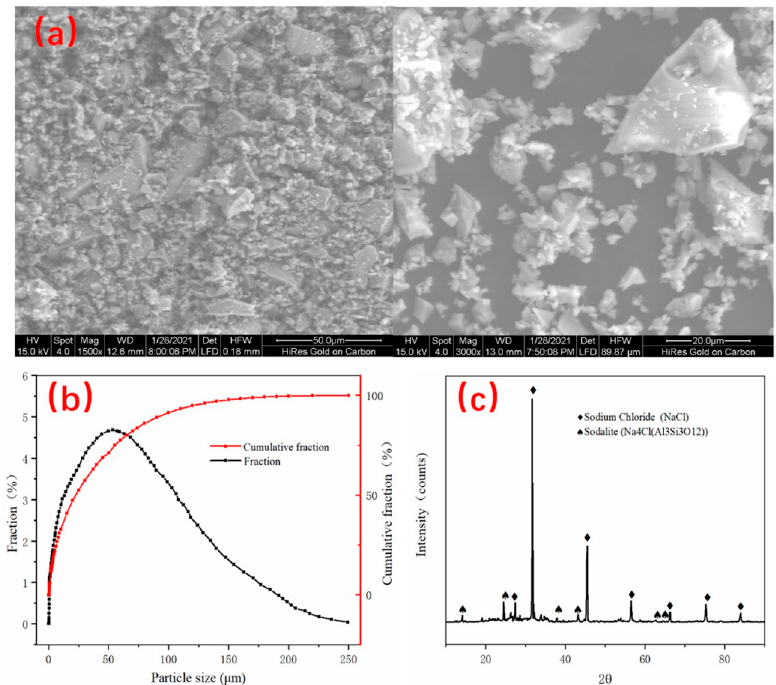
Figure 3. The basic characteristics of fly ash: ( a ) morphology under different electron microscope magnifications; ( b ) particle size distribution, and ( c ) XRD spectra.